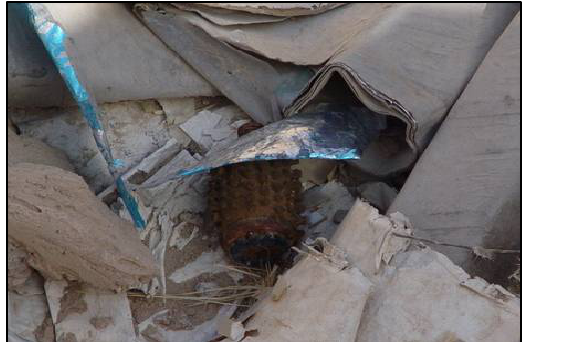
Figure 4 – Positioning an IED in cardboard waste Рис . 4 – Установка СВУ в картонных